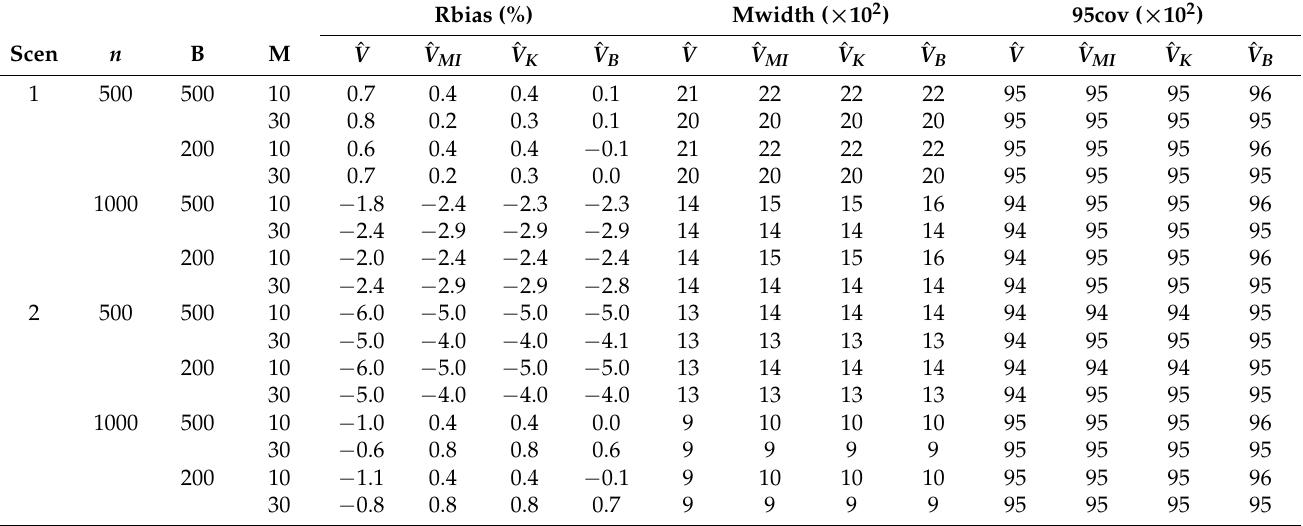
Table 2. Simulation results for the linear regression mean estimation. Rbias (%) Mwidth ( × 10 2